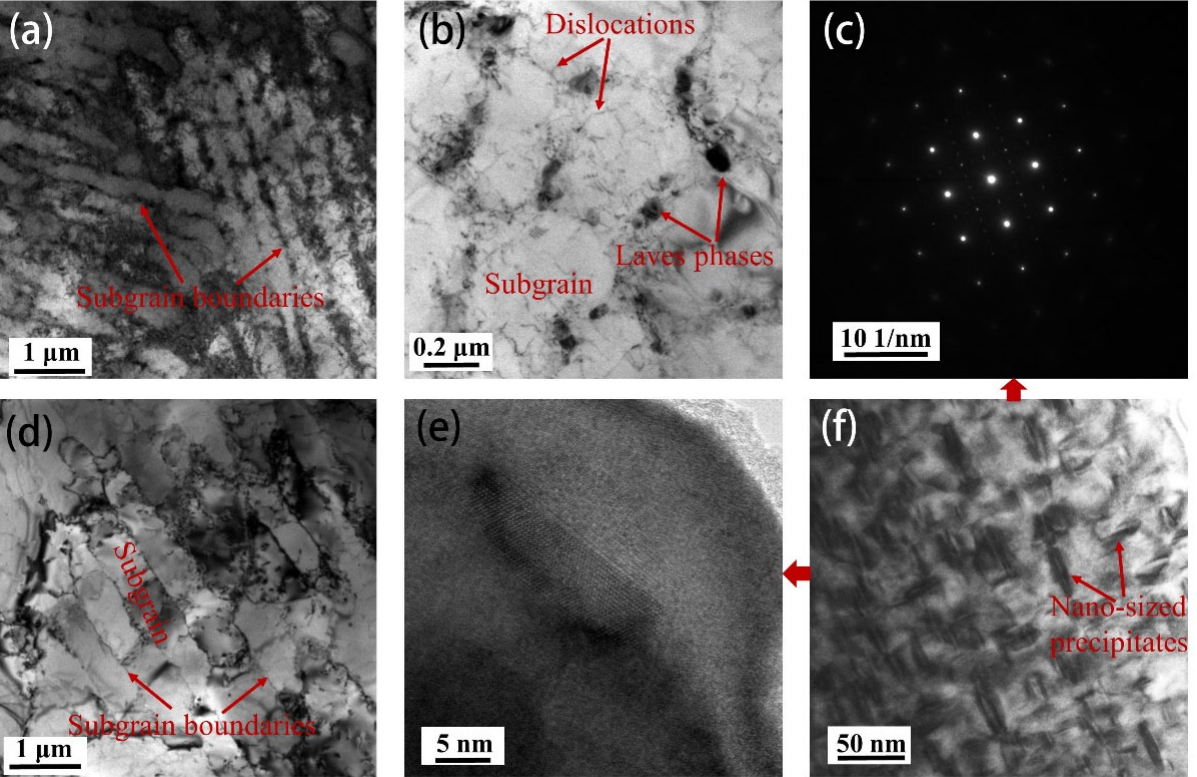
Figure 5. TEM images showing the substructures and precipitates of ( a , b ) as-printed and ( c – f ) heat-treated nickel-based superalloy samples.